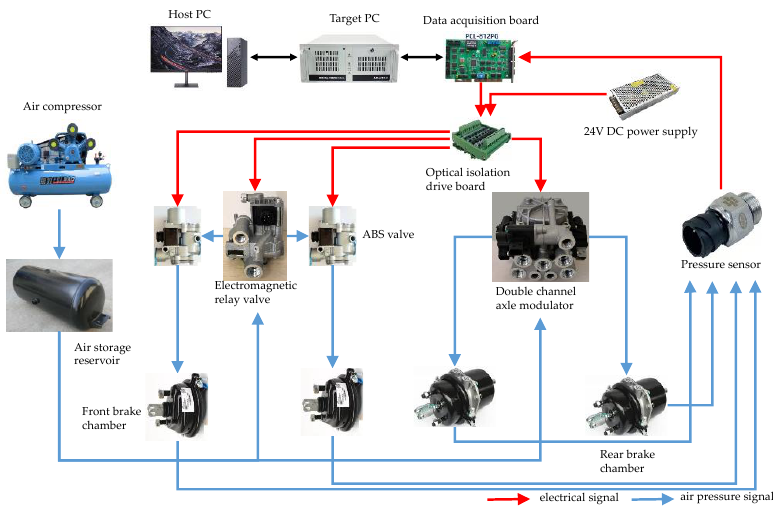
Figure 17. Configuration of the test platform.